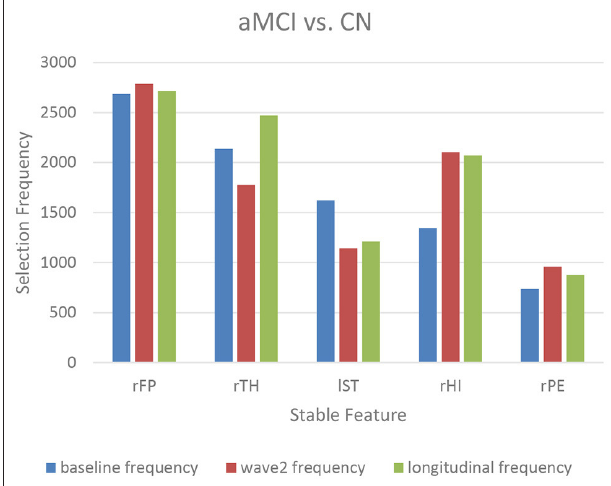
FIGURE 3 | The selection frequencies of the stable features for aMCI vs. CN classification. The baseline, wave-2 or longitudinal frequency are the selection frequencies of the feature measured at baseline, wave-2 or longitudinally, respectively. The selection frequency (between 0 and 3,000) of each feature is indicative of the discriminative power for classification. Thickness of right frontal pole is stable across time. Volume of right thalamus and left superior temporal provides more information in former time point, while the volume of right hippocampus is more discriminative in later time point. rFP, right frontal pole thickness; rTH, right thalamus volume; lST, left superior temporal thickness; rHI, right hippocampus volume; rPE, right pericalcarine